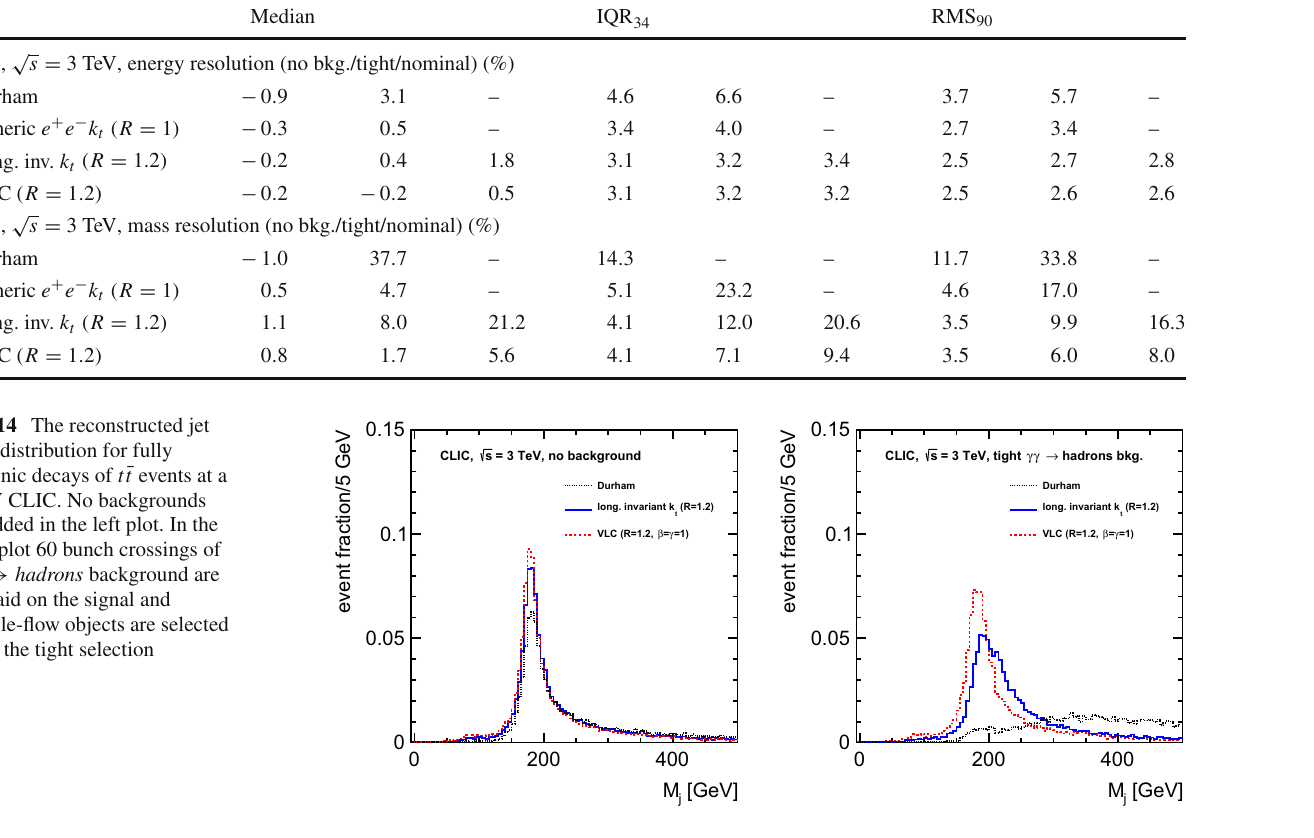
Table 3 The bias and resolution of the energy and mass measurements (RMS 90 ). All results are obtained by comparing the jet energy recon- structed from particle-flow objects to the jet of stable MC particles from ofreconstructedtopjetsintop-quarkpairproductionwithfullyhadronic the signal event. The performance of the classical e + e − algorithm is top-quark decay at a centre-of-mass energy of 3 TeV. Results are pre- sented for the median response and two estimates of the resolution: the such that the figures-of-merit cannot be estimated reliably under nomi- nal background conditions (indicated by “–” entries in the table) 34% inter-quantile range (IQR 34 ) and the RMS of central 90% of jets Median IQR 34 RMS 90 √ s = 3 TeV, energy resolution (no bkg./tight/nominal) (%) CLIC,